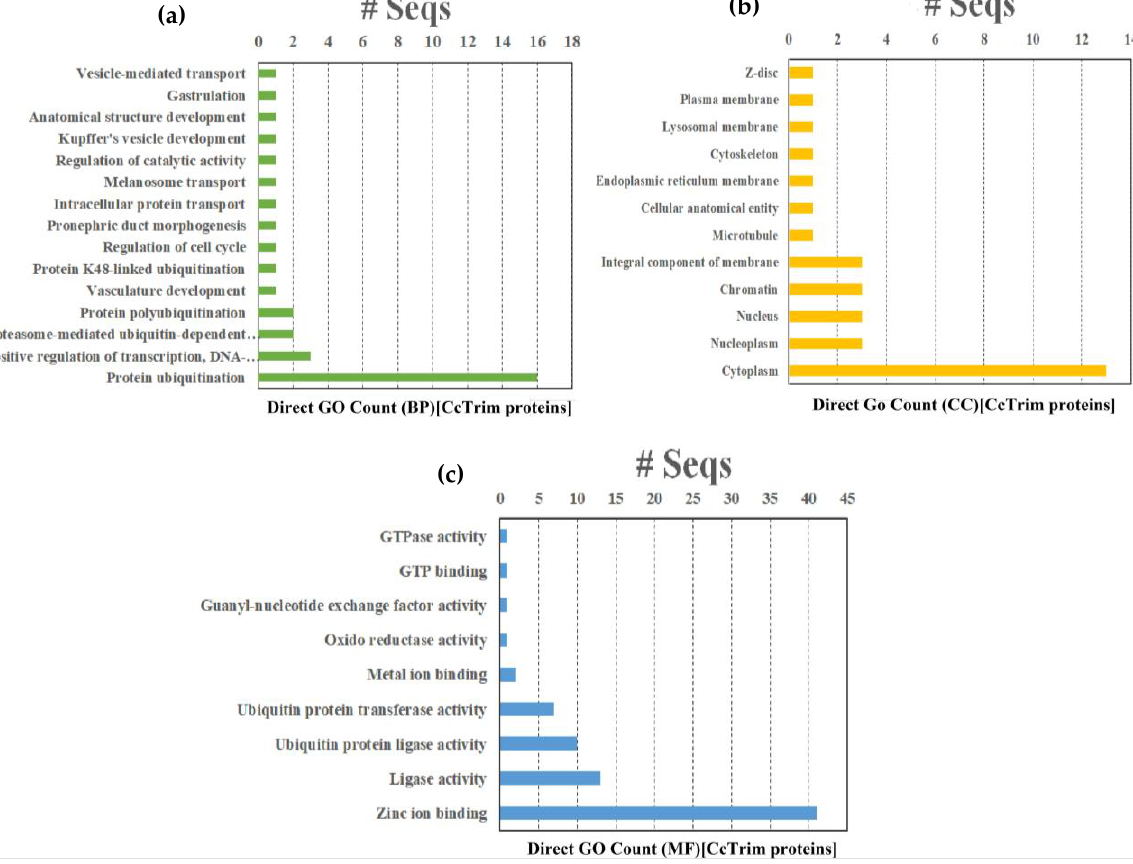
Figure 9. Gene Ontologies ( a ) Graph representing the Gene Ontology distribution in biological processes, ( b ) graph representing the Gene Ontology distribution in cellular components, ( c ) graph depicting the Gene Ontology distribution in molecular function.